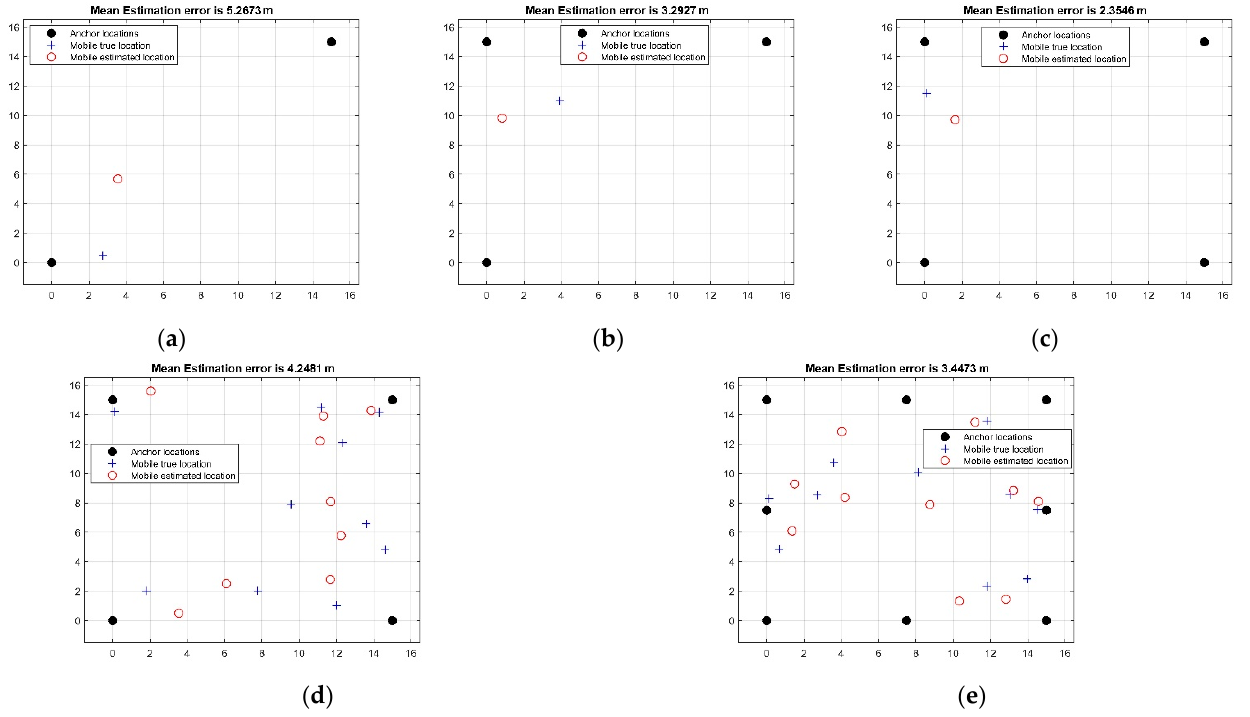
Figure 9. Localization results for C 1 C 2 . ( a ) Localization estimation of one sensor node with two anchor nodes. ( b ) Localization estimation of one sensor node through trilateration. ( c ) Localization estimation of one sensor node through four anchor nodes (Multilateration). ( d ) Localization estimation of ten sensor nodes through four anchor nodes (Multilateration). ( e ) Localization estimation of ten sensor nodes through eight anchor nodes (Multilateration).